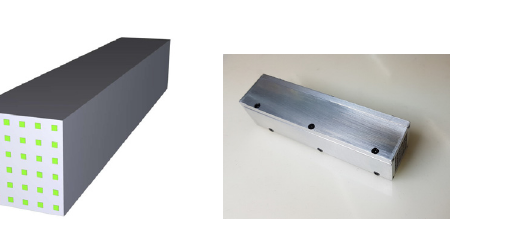
Figure 2. Scheme of the cell for “spaghetti” ECal and its